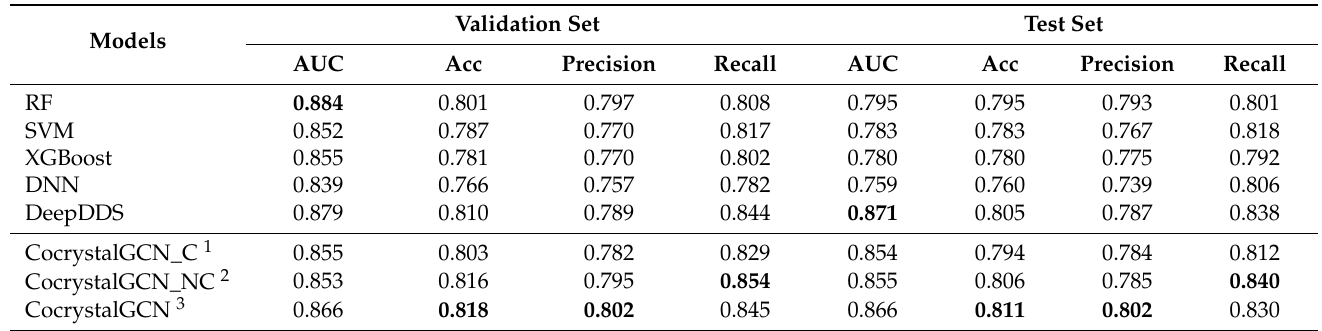
Table 1. Performance comparison of CocrystalGCN and baselines on validation and test